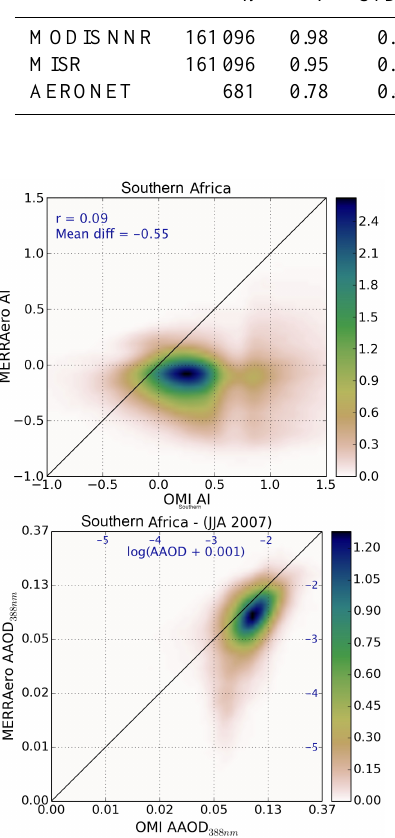
Figure 12. Comparison of MERRAero-simulated AI (top) and AAOD at 388nm (bottom) to OMI retrievals for the period JJA 2007 over the southern African region.